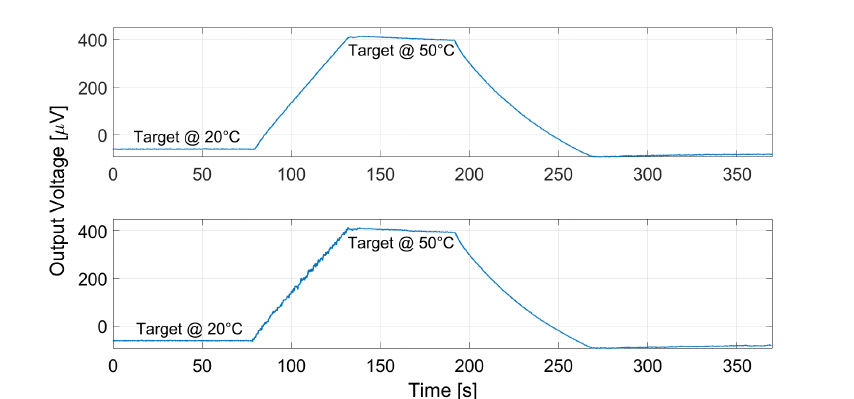
Figure 9. Measured thermopile E1 output with the black body at 10 cm distance and ambient temperature equal to 25 ◦ C. The black body temperature was varied as a ramp from 20 to 50 ◦ C.